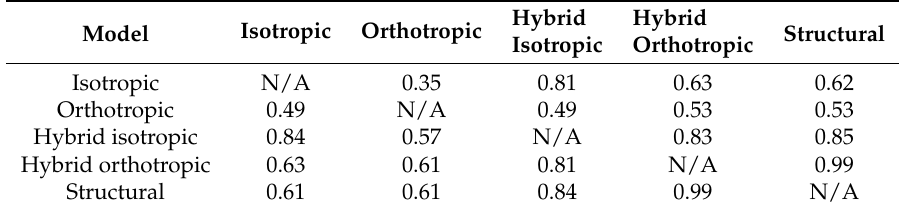
Table 6. Coefficients of determination between each pair of adaptive models for maximum principal strains (above table diagonal) and minimum principal strains (below table diagonal).